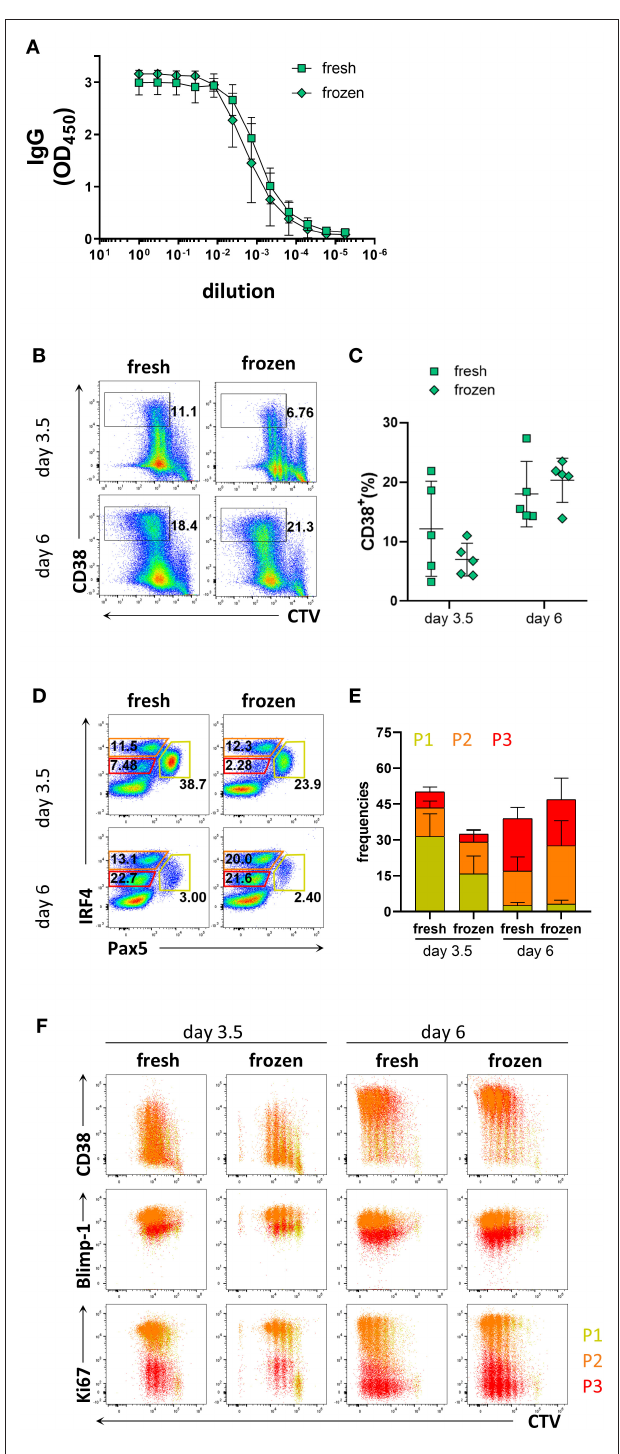
FIGURE 4 | Comparison of PC differentiation of B cells isolated freshly from PBMCs or from cryopreserved PBMCs. Total human B cells were isolated from fresh PBMCs and cryopreserved PBMCs. IgG production and PC differentiation were assessed in response to stimulation III. Cells were pre-gated on FSC-A/FSC-W to identify singlets and on FSC-A/SSC-A to identify lymphocytes. (A) Total IgG production from supernatant of cultured